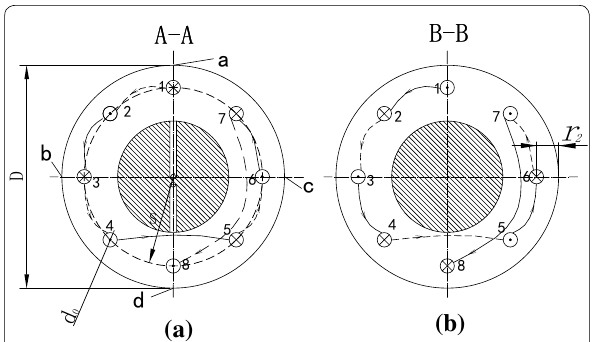
Figure 3 Work roll cross section diagram